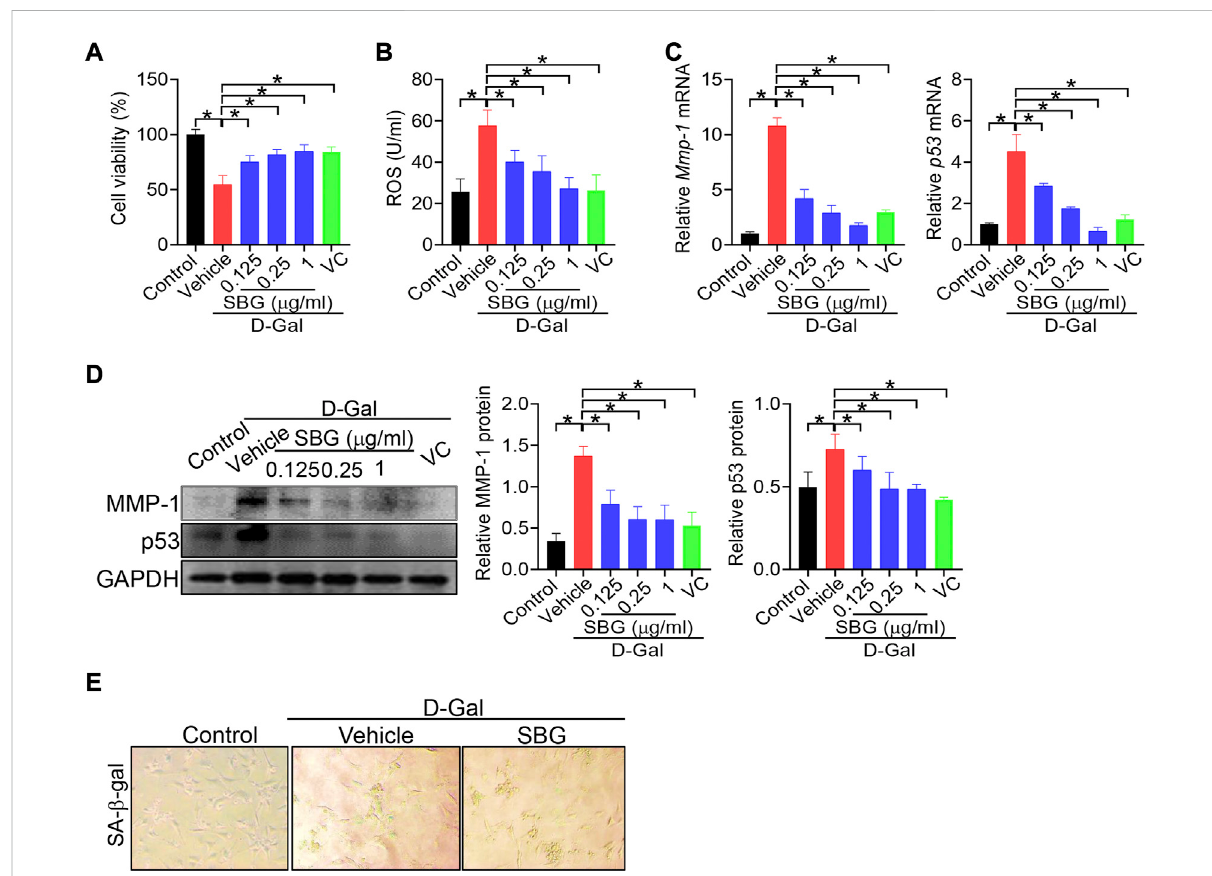
FIGURE 4 SBG attenuates D-gal-induced senescence in NIH3T3 cells . (A) Effects of SBG on the viability of D-gal-treated NIH3T3 cells. (B) Effects of SBG on ROS accumulation in D-gal-treated NIH3T3 cells. (C) Effects of SBG on Mmp-1 (left panel) and p53 (right panel) mRNA expression in D-gal- treated NIH3T3 cells. (D) Effects of SBG on protein expression of MMP-1 and p53 in D-gal-treated NIH3T3 cells. (E) Representative images showing SA- β -GalactivityinSBG-treatedsenescentNIH3T3cells.InpanelsA – D,dataaremean±SD( n =3).* p < 0.05(one-wayANOVAandBonferroni post hoc test).